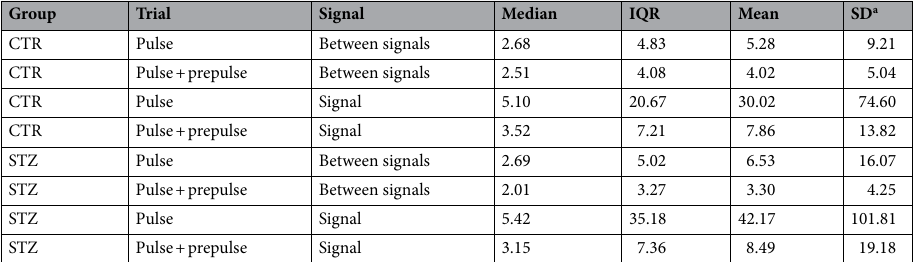
Table 1. Descriptive statistics of the raw data obtained from PASTA. All results are presented in grams. a Very high standard deviation values of raw data obtained from PASTA indicate greater variation and in fact reflect the change we expected to see as the definition of the signal period is defined by the time window and includes both the signal and the noise recorded during the sampling segment. The best approach to quantification of PASTA-obtained changes is still to be determined, as a more detailed mathematical approach might increase the sensitivity and specificity of